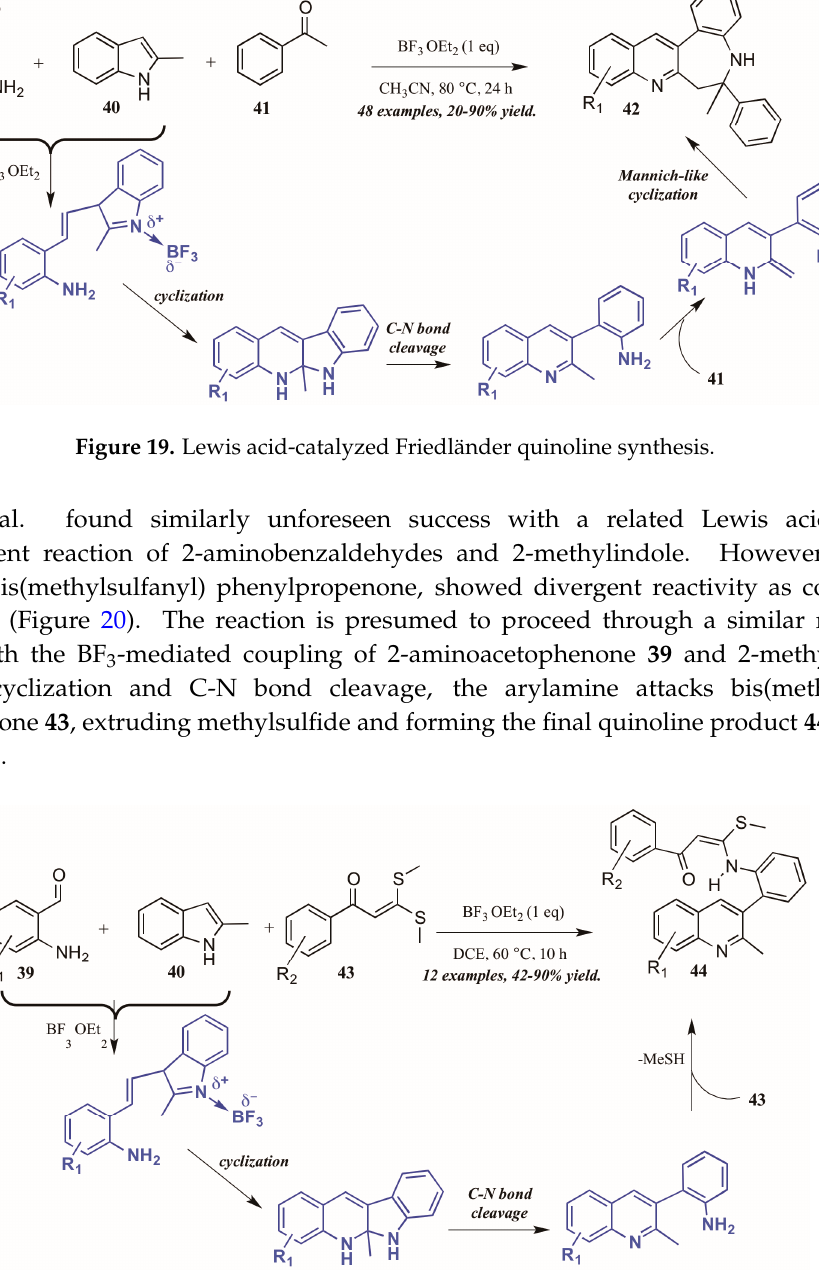
Figure 20. Lewis acid-catalyzed multicomponent Friedländer quinoline synthesis with dithioethers.